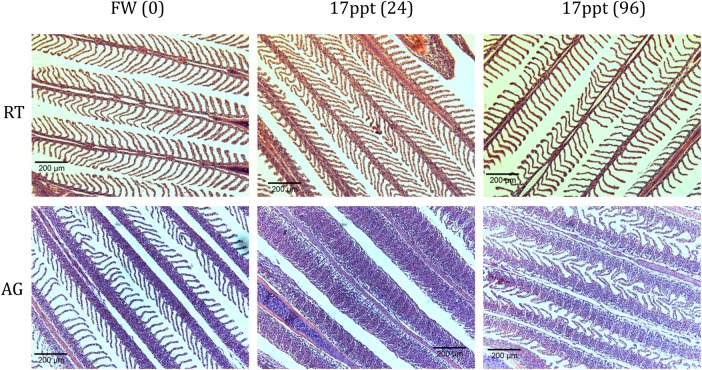
Light microscopy images showing comparison between rainbow trout (RT; top row) and Arctic grayling (AG; bottom row) gills in control freshwater (FW) conditions and after 24 and 96 h exposure to 50% seawater (17 ppt).